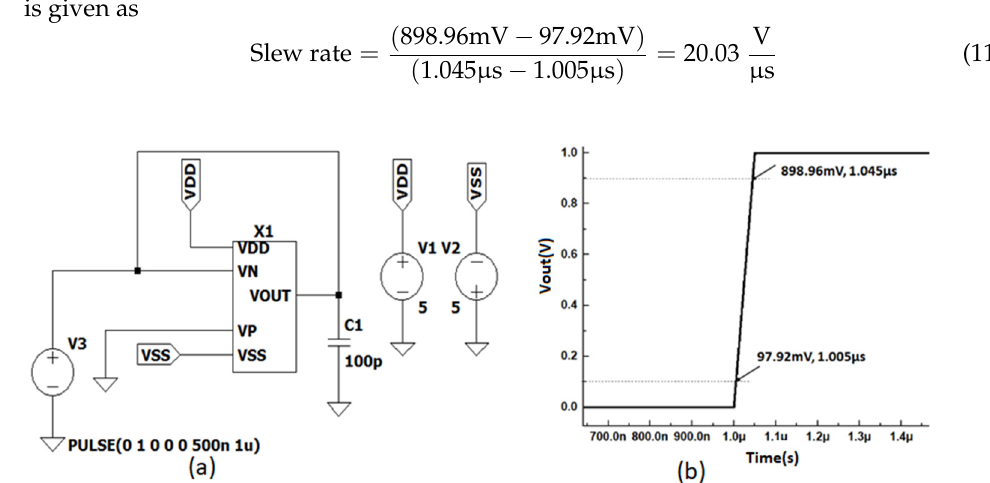
Figure 5. ( a ) Slew rate simulation model. ( b ) Simulation output.